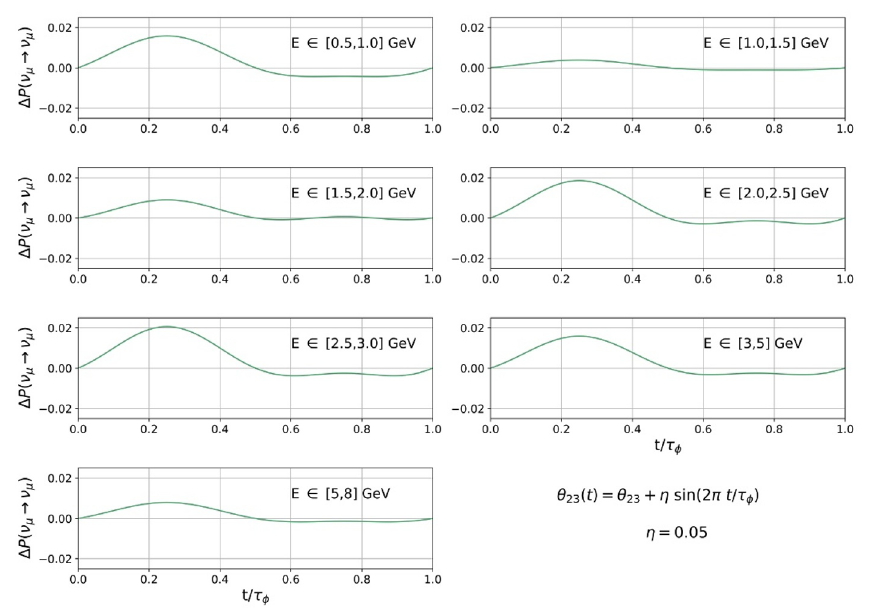
Figure 1 . The difference in ν µ disappearance oscillation probability ∆ P ( t ) ≡ P µµ ( t ) − P µµ (0) at DUNE for a modulating θ 23 assuming η = 0 . 05 for several energy bins. We have assumed normal mass ordering and the best fit values of oscillation parameters from ref. [44], namely ∆ m 2 2 . 5 × 10 − 3 eV 2 , and sin 2 θ 23 = 0 . 55